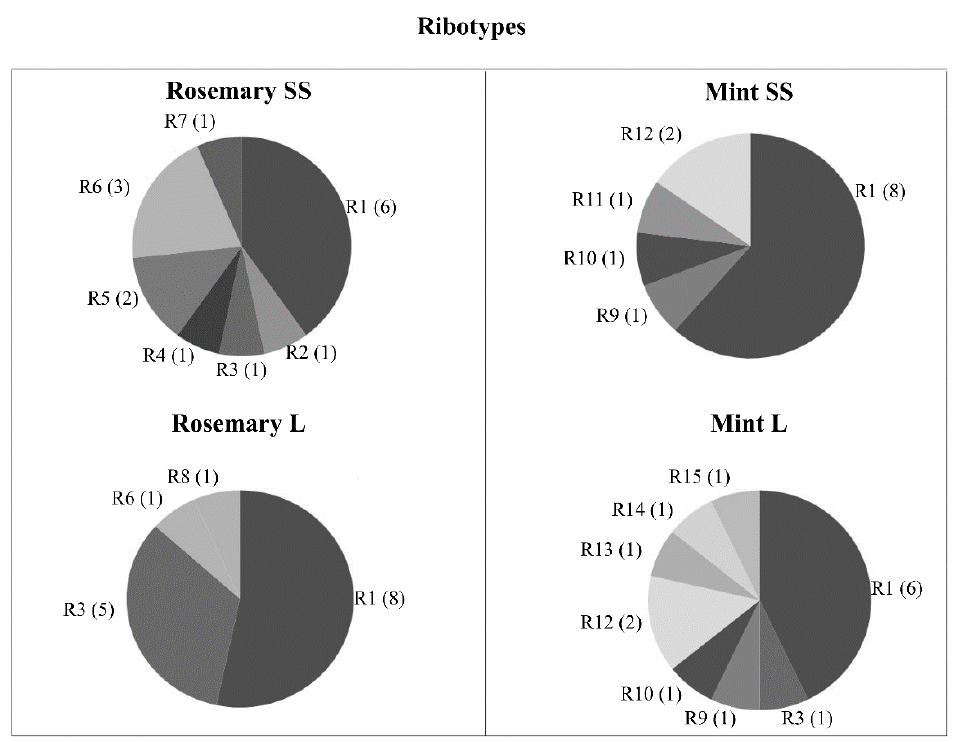
Figure 4. Ribotypes present in M. spicata and R. officinalis obtained by amplified ribosomal DNA restriction analysis (ARDRA; R: ribotype, number: number of ribotypes, and number in parentheses: number of isolates corresponding to each ribotype).